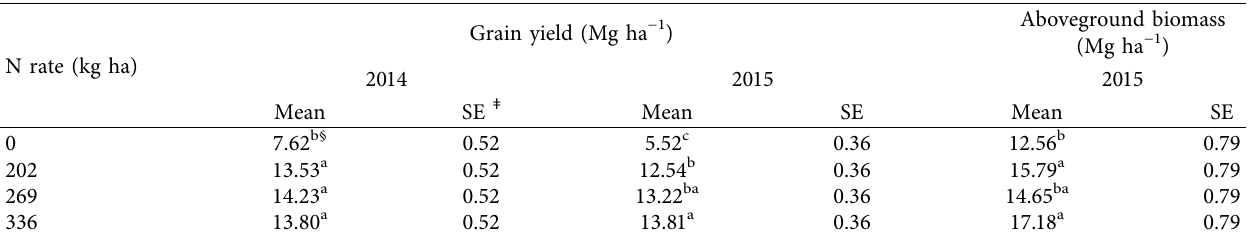
Table 6: Grain yield and aboveground biomass differences between years and N rates (0, 202, 269, and 336kg ha − 1 ) at the TVREC. N rate (kg